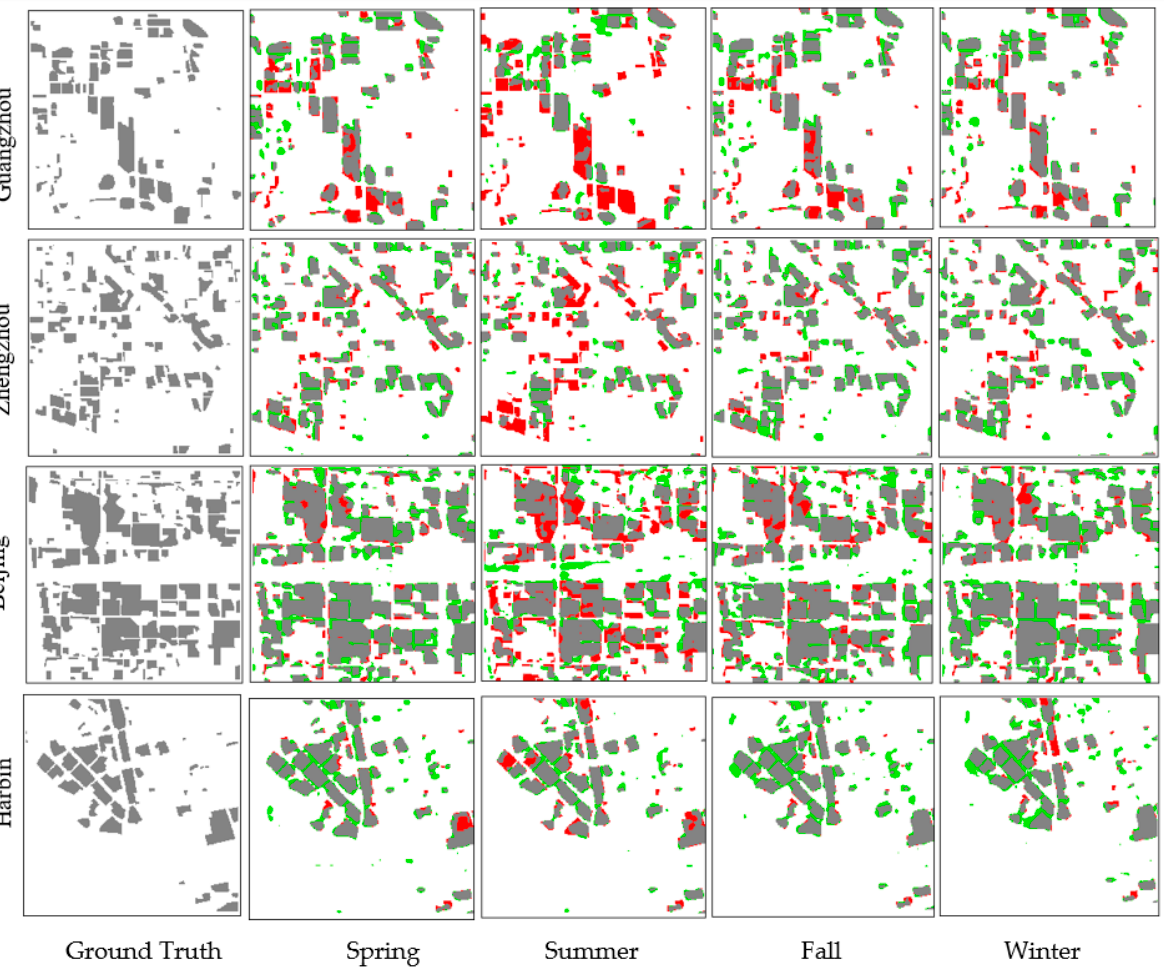
Figure 10. Ground truths and predicted HRBs in test1 in four regions in four seasons by FCN models trained on seasonally and regionally combined samples. Gray refers to true HRBs, red refer to omission errors, and green refer to commission errors.